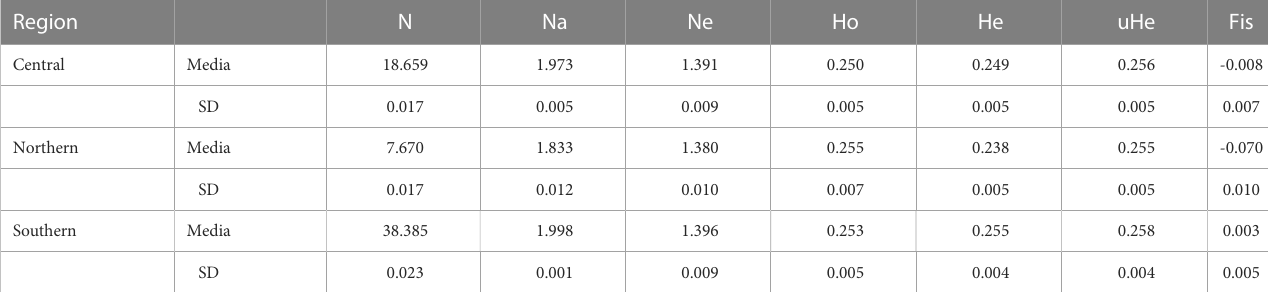
TABLE 2 Mean values and standard deviations of general descriptors of genetic diversity of 66 Bothus robinsi larvae and adults. Region N Na Ne Ho He